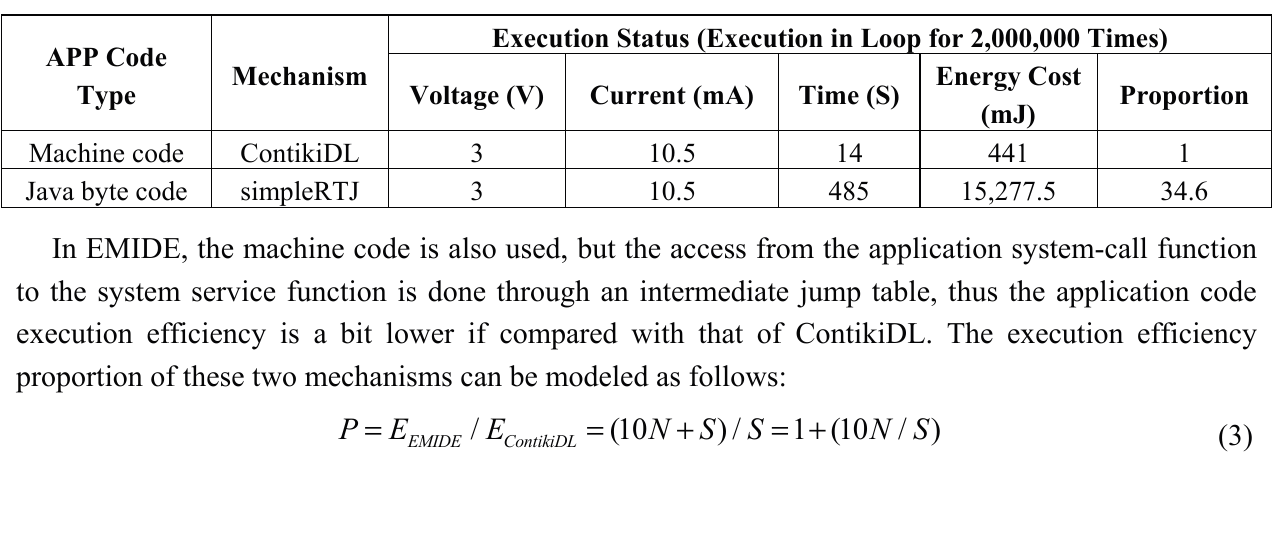
Table 7. Comparison of the application code execution